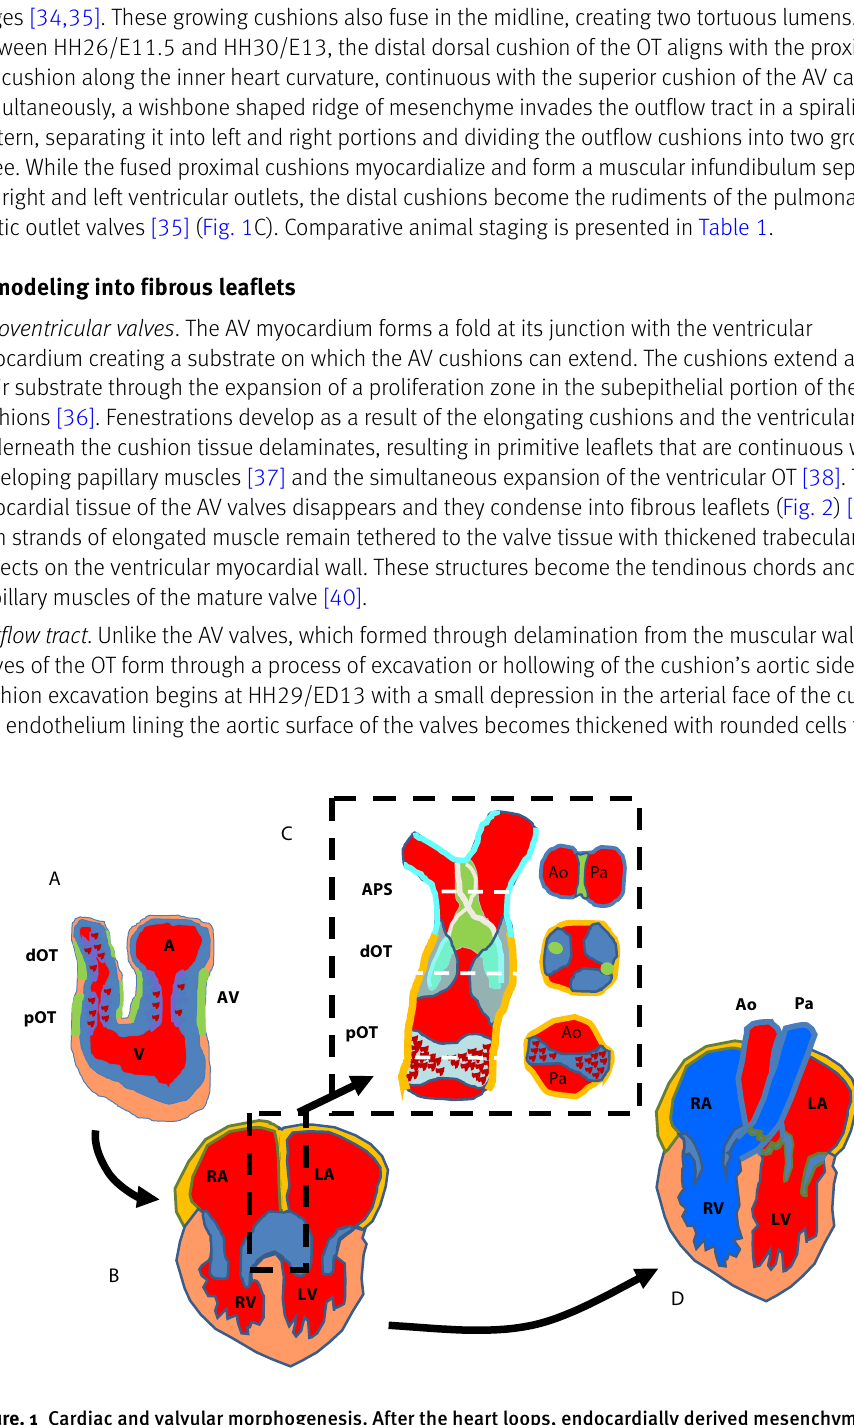
Figure. 1 Cardiac and valvular morphogenesis. After the heart loops, endocardially derived mesenchyme (blue) invades the cardiac jelly (blue) in the atrioventricular (AV) junction and distal and proximal outflow tract (dOT and pOT respectively) segments (red cells) (A). These primitive structures, dubbed cushions, grow into the early atrioventricular (B) and semilunar valves (C) of the now septated four chambered fetal heart. Note the invading aorticopulmonary septum (APS, green) that spirals through the outflow tract to create separate pulmonic (Pa) and aortic (Ao) outlet arteries, each with their own valve primordia at the dOT site, while at the pOT site the cushions become myocardialized to form the pulmonary infundibulum. The valves become fully condensed into thin fibrous tissues in the mature heart (D). A, atrium; V, ventricle; R, right; L,